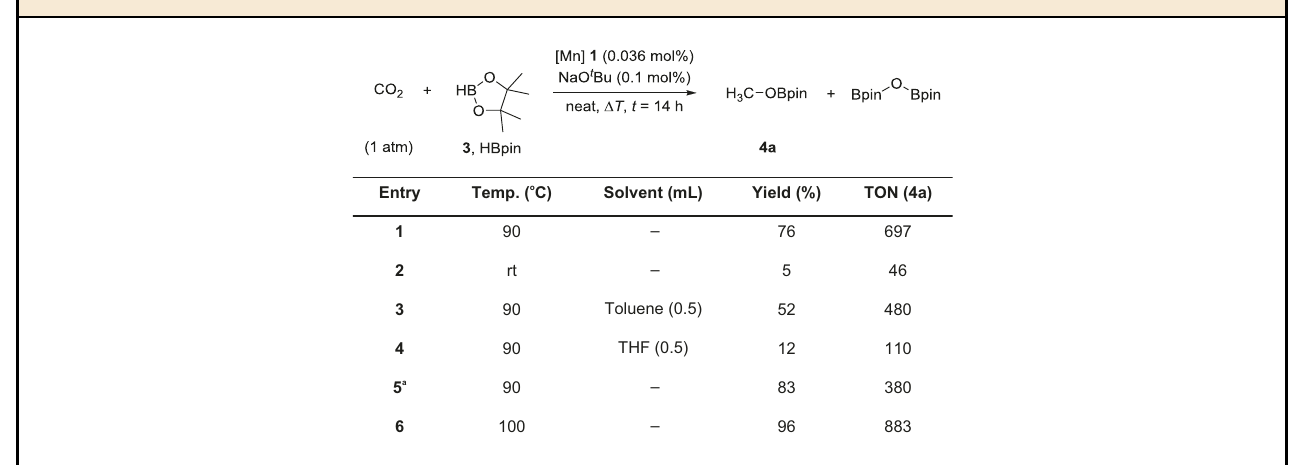
Table 3 Hydroboration of CO 2 using Mn complex 1 as